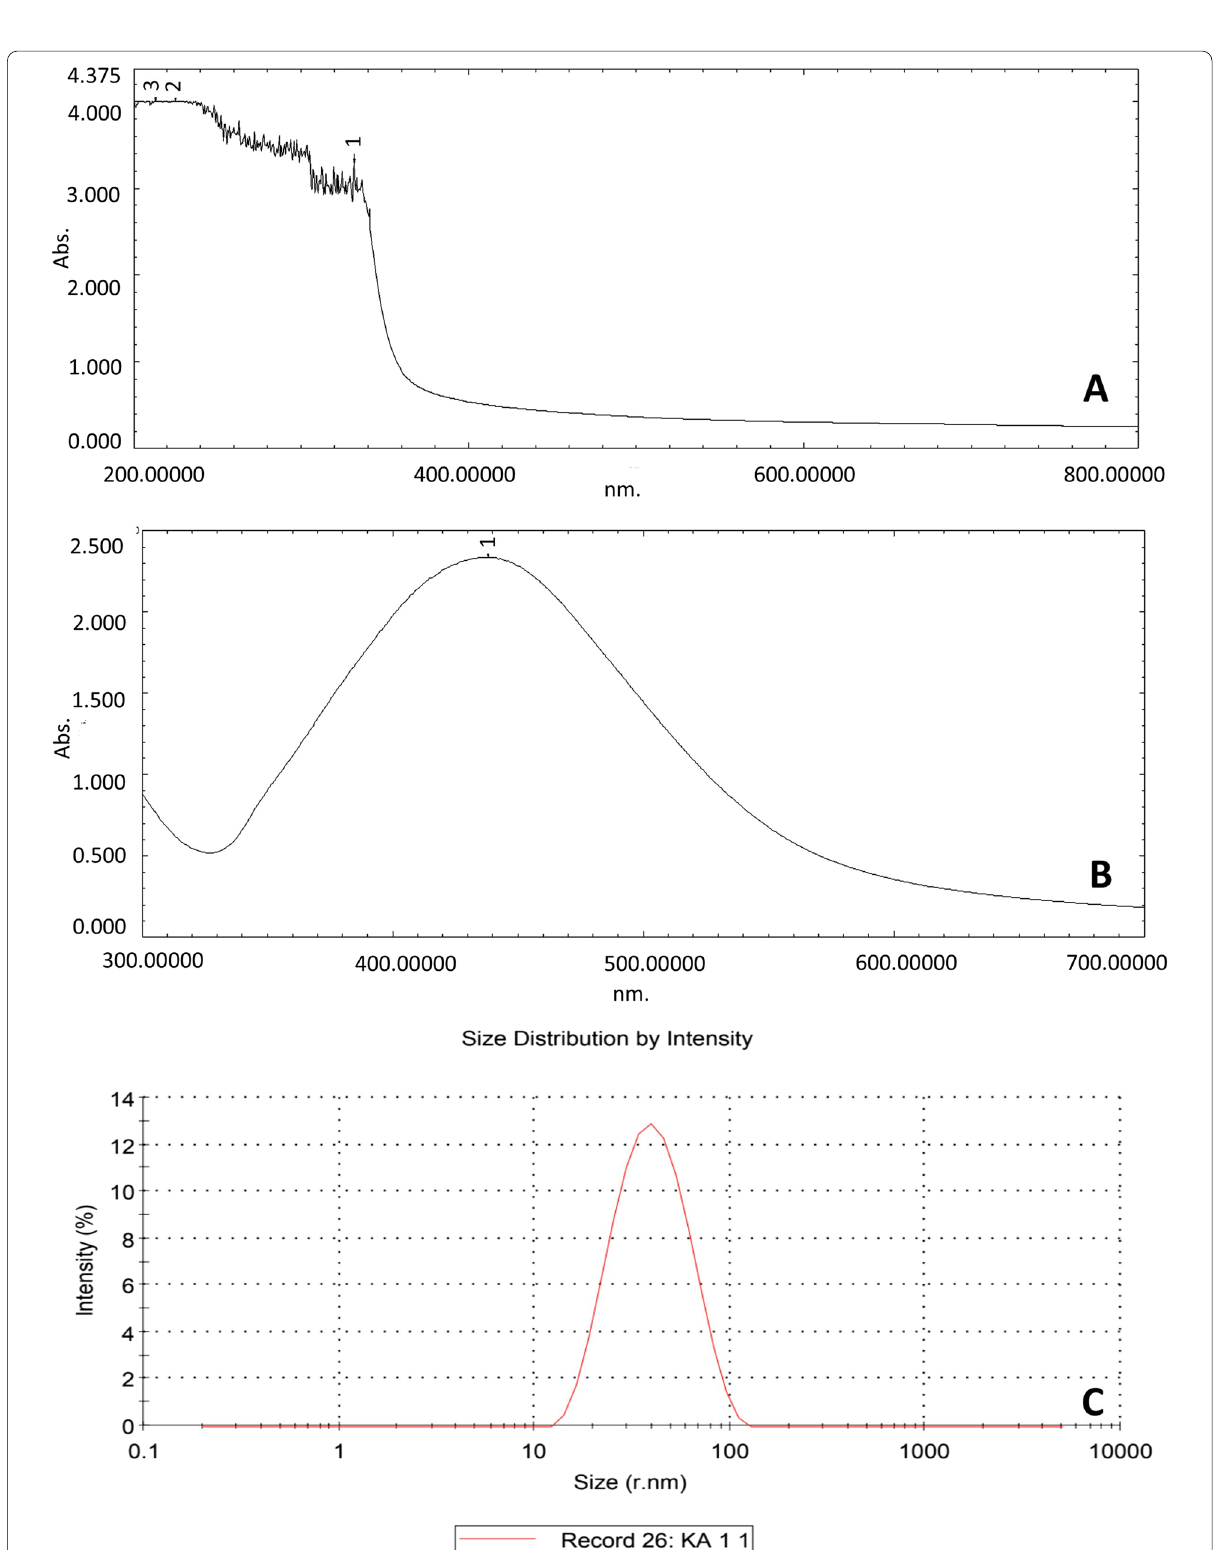
Fig. 2 A UV-visible spectrum of silver nanoparticle synthesized from Kaempferia angustifolia rhizome. B UV-visible spectrum of Kaempferia angustifolia rhizome extract. C DLS spectrum of silver